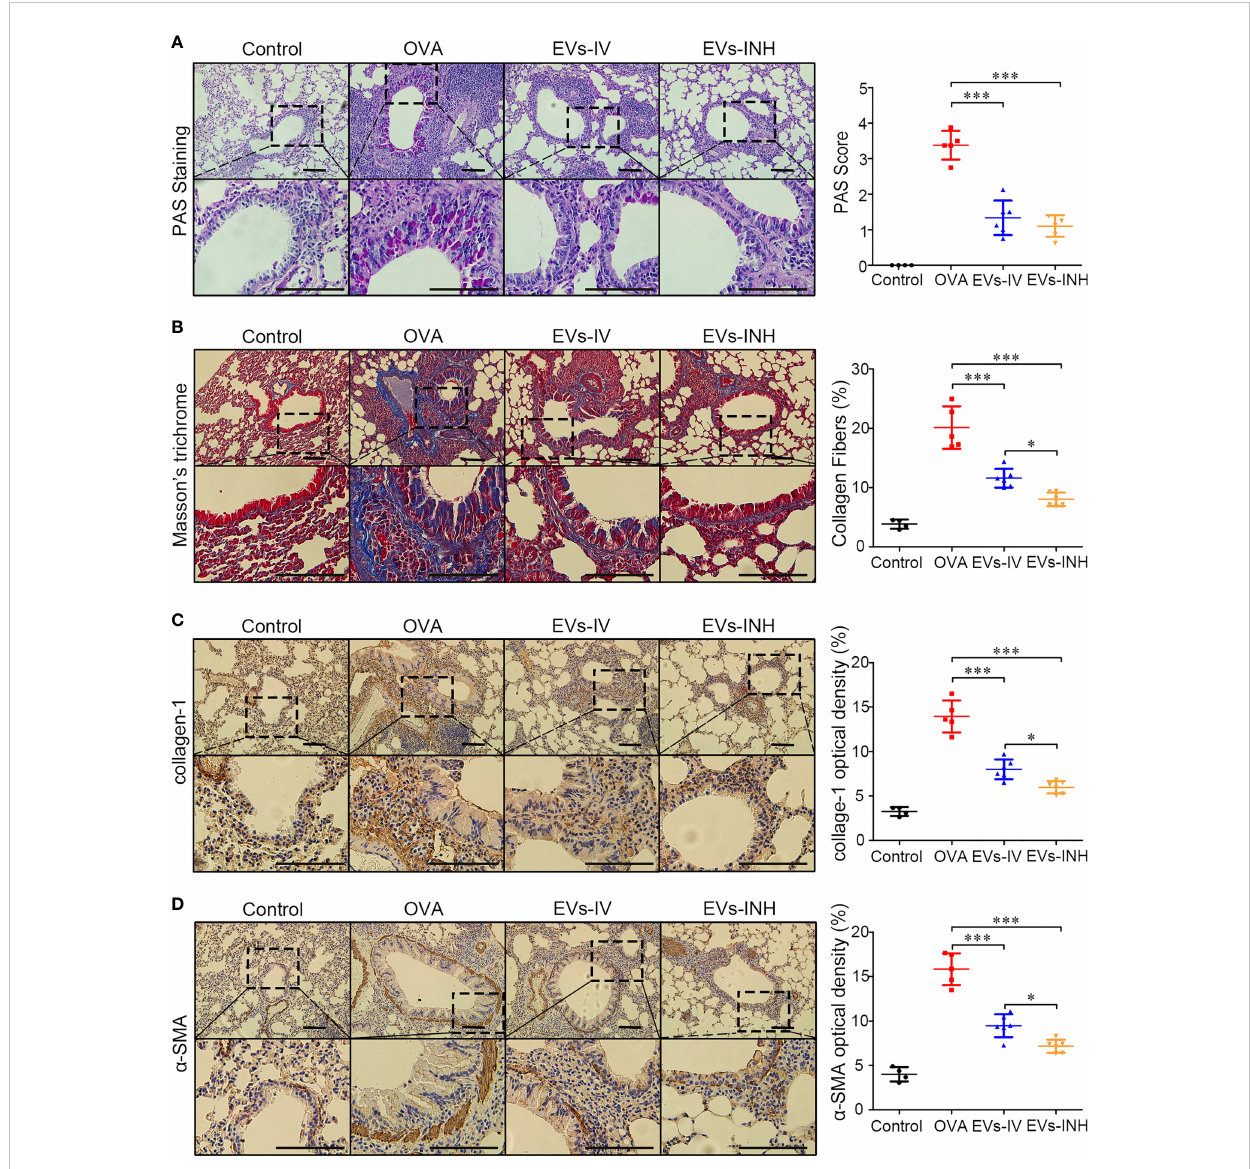
FIGURE 5 EVs-INH treatment prevented the airway remodeling in chronic asthma mice. (A) periodic acid-schiff (PAS) stained lung sections from each group (black bar = 100 m m), the images are shown at ×200 (up panel) and ×400 (down panel), and the goblet cell hyperplasia was quanti fi ed by PAS score. (B) Representative photomicrographs of airway stained with Masson trichrome (black bar = 100 m m), the images are shown at ×200 (up panel) and ×400 (down panel), and the percentage of collagen fi ber content in airway was measured. Collagen-1 (C) and a -SMA (D) levels in airway were determined by immunohistochemistry staining, the images are shown at ×200 (up panel) and ×400 (down panel), and the percentage of immunostained area was quanti fi ed. Each dot represents data from one animal and n = 4-6 per group. One-way analysis of variance (Tukey Kramer post hoc tests): * P < 0.05, *** P <